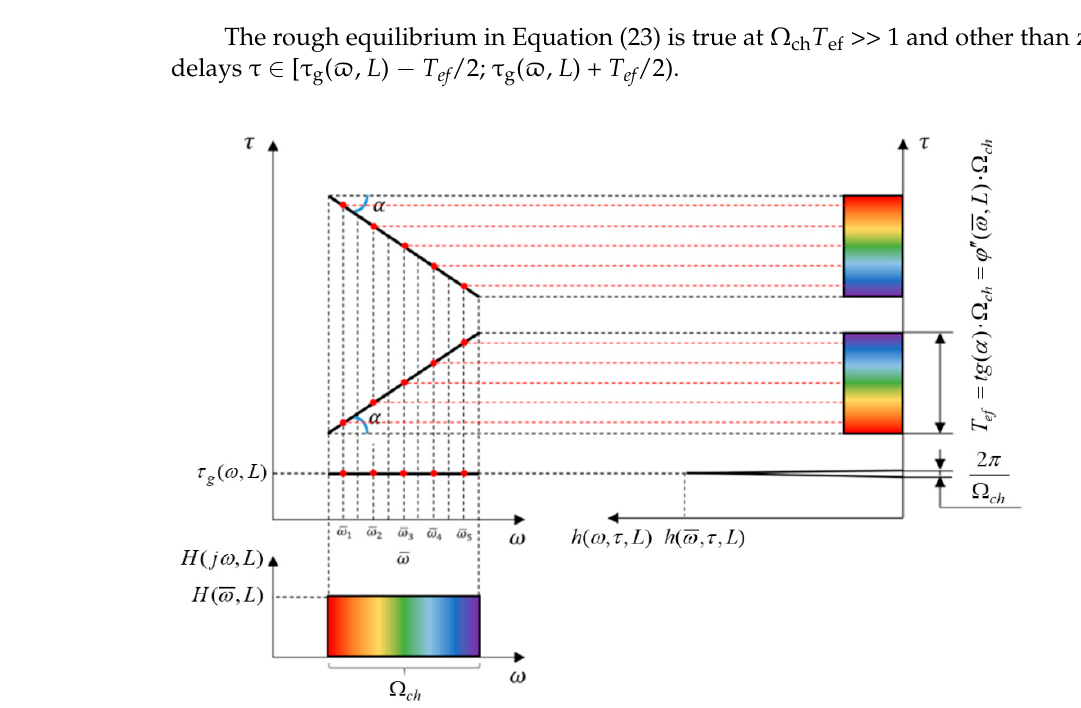
Figure 2. The chirplets with rectangular duration window in the case of normal and anomalous dispersions and its pulse characteristics at soliton mode during propagation in the medium. According to Equation (23), the pulse characteristic of the channel is a chirplet by fast time τ , that is second-order dispersion leads to chirping of impulse characteristic. The rate of the frequency changing in the chirplet is positive for normal dispersion and negative for anomalous dispersion.